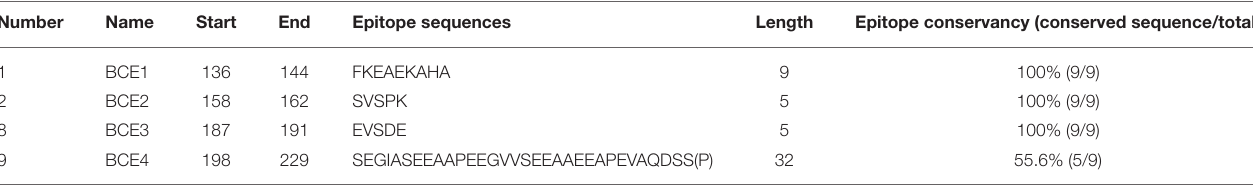
TABLE 5 | Common epitopes between B-cell linear and conformational peptides obtained from Anaplasma marginale OmpA protein by using BepiPred, ABCpred, BepiPred 2.0 and CBTope, and epitope conservancy